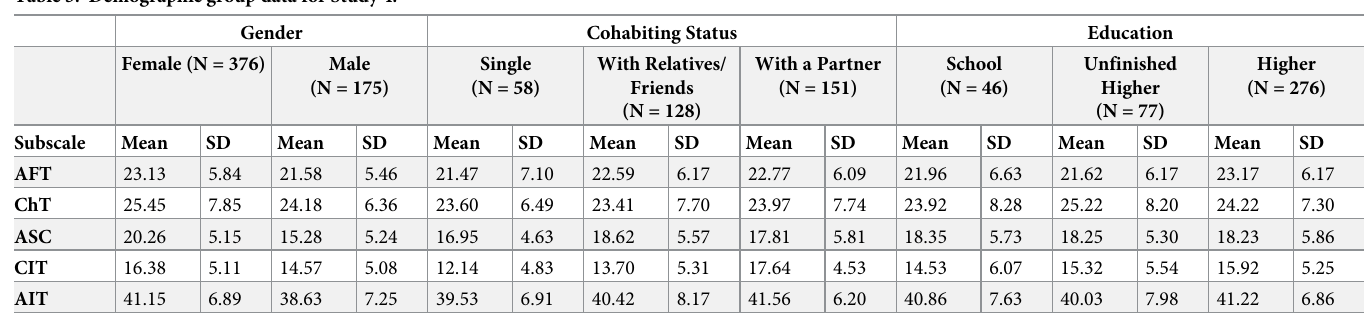
Table 5. Demographic group data for Study